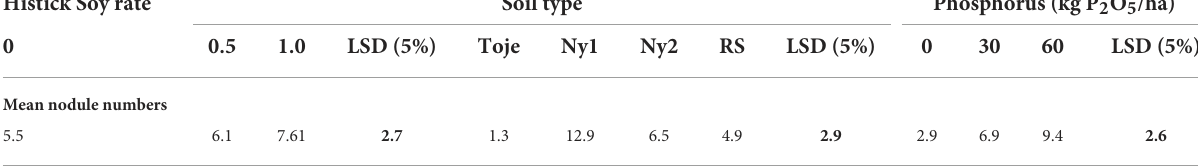
TABLE 4 Effect of Histick Soy, soil type, and phosphorus on nodule numbers * . Histick Soy